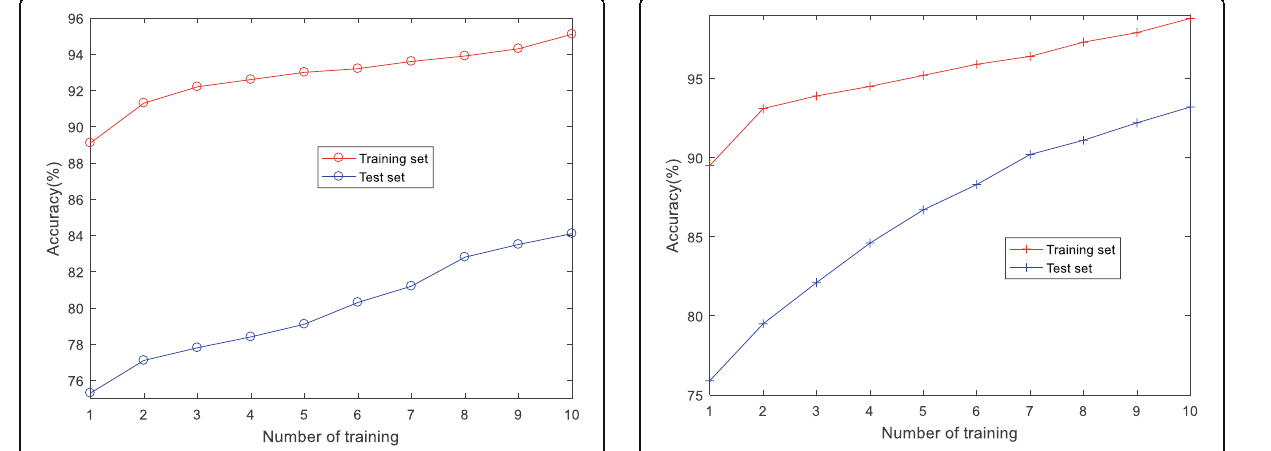
Fig. 5 Result diagram of unmixed model classification